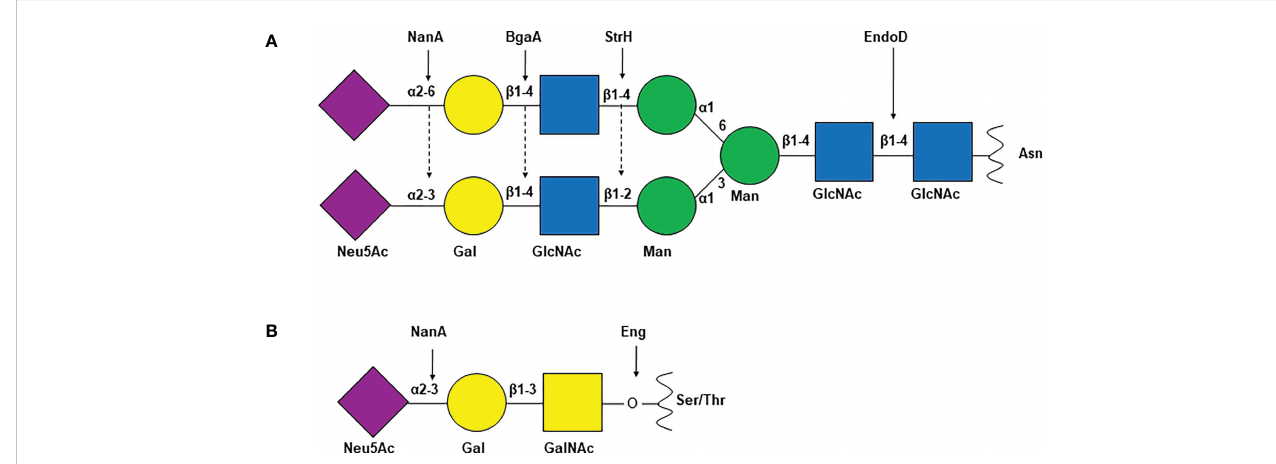
FIGURE 1 Common S. pneumoniae glycosidases and their glycan substrates. Schematic representation of (A) complex N-linked glycan and (B) core-1 O-linked glycan. Arrows indicate the target glyosidic bond of the enzyme above. NanA, neuraminidase A; BgaA, b -galactosidase A; StrH, N-acetylglucosaminidase StrH; EndoD, Endo- b -N-acetylglucosaminidase; Eng, O-glycosidase; Neu5Ac, N-acetylneuraminic acid or sialic acid; Gal, galactose; GlcNAc, N- acetylglucosamine; Man, mannose; GalNAc, N-acetylgalactosamine; Asn, asparagine; Ser, serine; Thr,